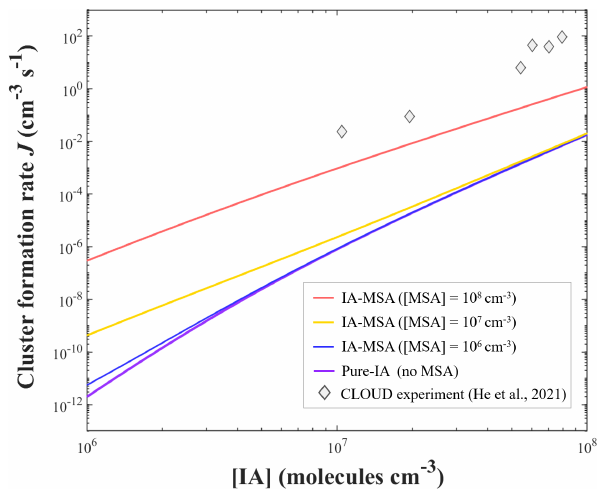
Figure 4. Enhancement strength R of MSA on cluster forma- tion rates under different atmospheric conditions: T = 218 to 298K (blue cones, [IA] = 10 7 and [MSA] = 10 7 molec.cm − 3 ), [MSA] = 10 6 to 10 8 molec.cm − 3 (red cones, T = 278K and [IA] = 10 7 molec.cm − 3 ), [IA] = 10 6 to 10 8 molec.cm − 3 (pur- ple cones, T = 278K and [MSA] = 10 7 molec.cm − 3 ), and CS = 2.0 × 10 − 3 s − 1